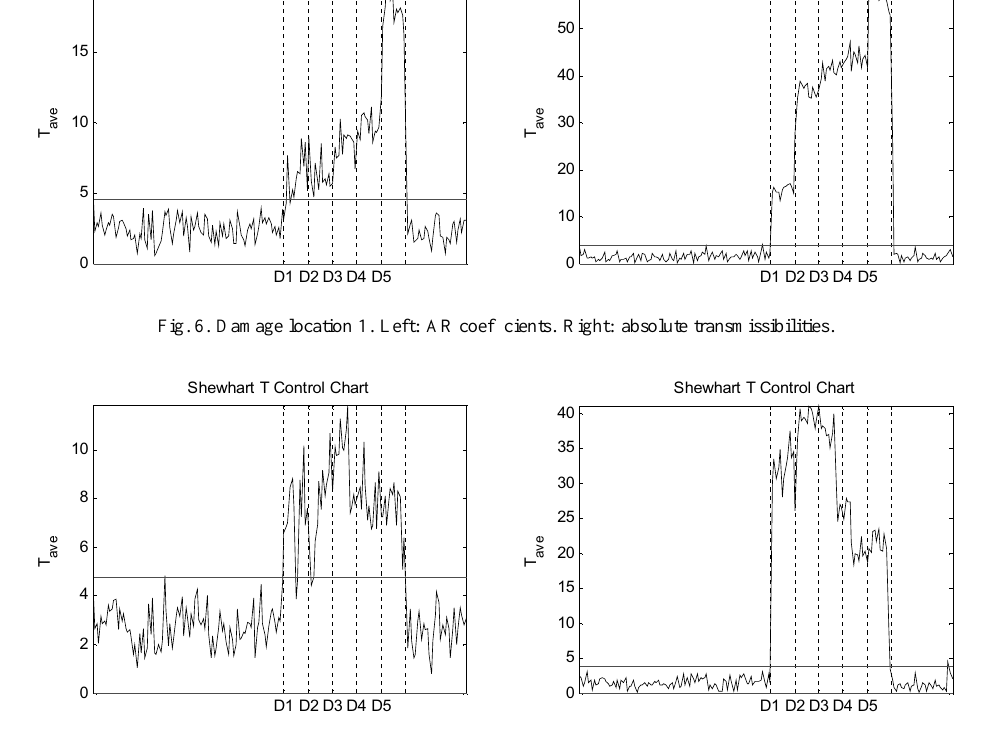
Fig. 7. Damage location 2. Left: AR coefficients. Right: absolute